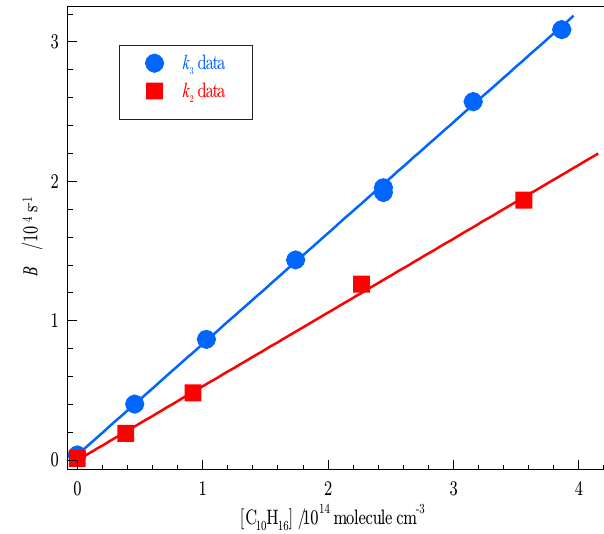
Figure 7. Plot of typical LIF profiles recorded for three α -pinene concentrations, used to determine k 2 (296K). For all experiments photolysis (R4) at t = 0 generated [OH] ≈ 5 × 10 11 moleculecm − 3 in P = 97Torr (air). Unweighted fits with (Eq. 2) yield B parameters for [ α -pinene] = 3 . 9 × 10 13 moleculecm − 3 (black squares), B = ( 1921 ± 90 ) s − 1 ; [ α - pinene] = 9 . 2 × 10 13 moleculecm − 3 (red triangles), B = ( 4819 ± 213 ) s − 1 and [ α -pinene] = 35 . 6 × 10 13 moleculecm − 3 (blue cir- cles), B =(17944 ± 615)s − 1 .